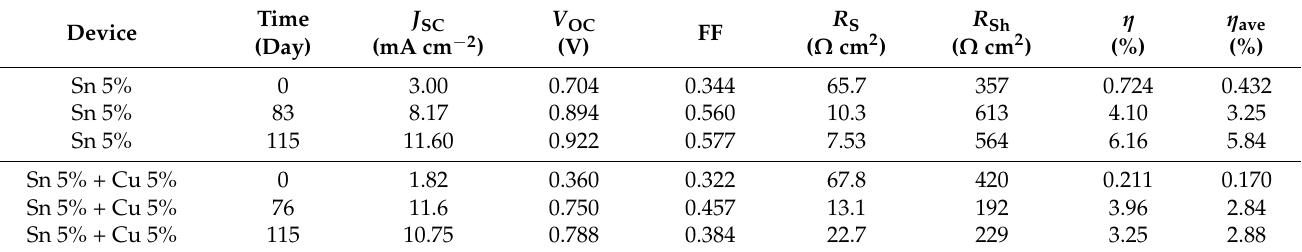
Table 5. Photovoltaic parameters of the perovskite solar cells without FA and DPPS layer.